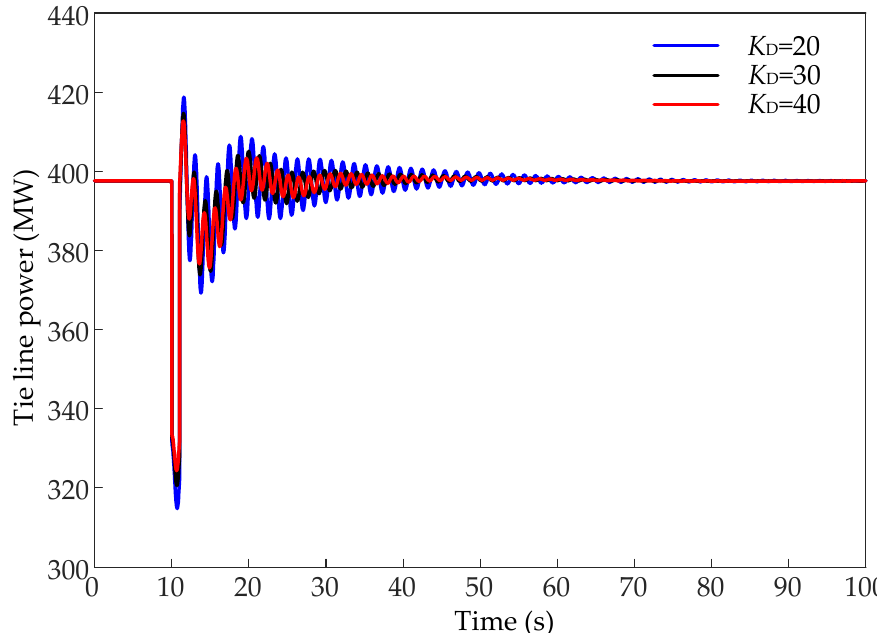
Figure 6. The response curves of tie-line power with different values of the gain K D ( K P = 20).